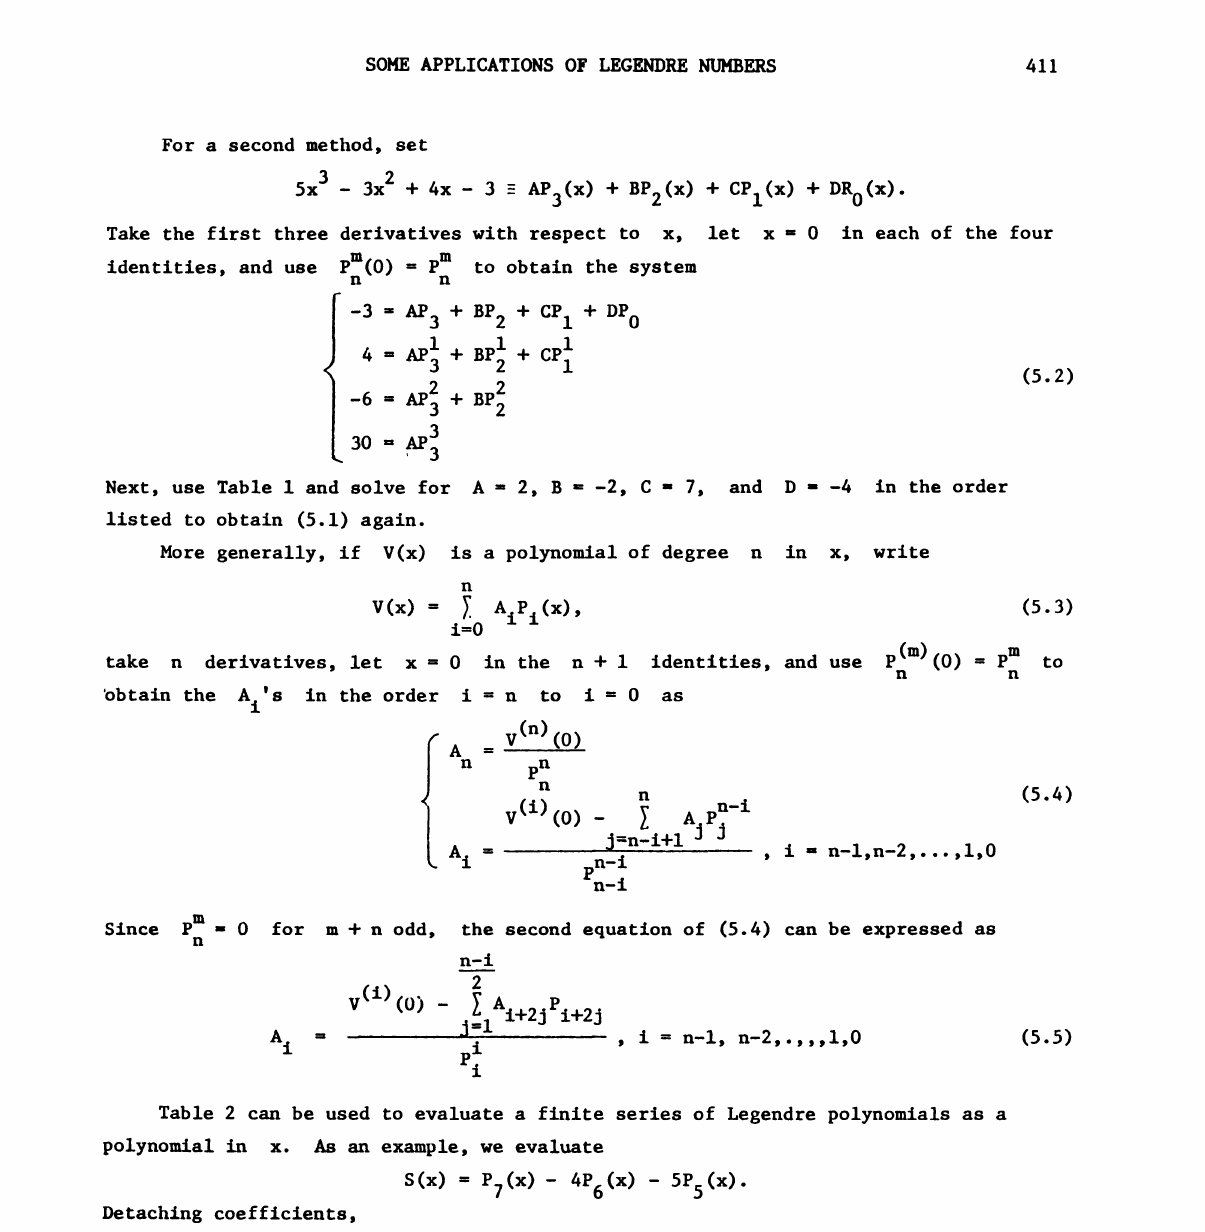
Table 2 can be used to evaluate a finite series of Legendre polynomials as a polynomial in